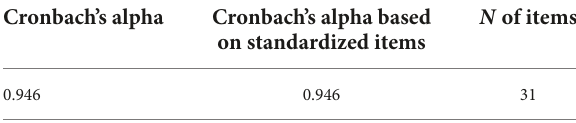
TABLE 5 Kaiser-Meyer-Olkin measure of sampling adequacy (KMO) and Bartlett’s test.